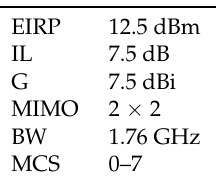
Table 2. Tensorcom 802.11ad module